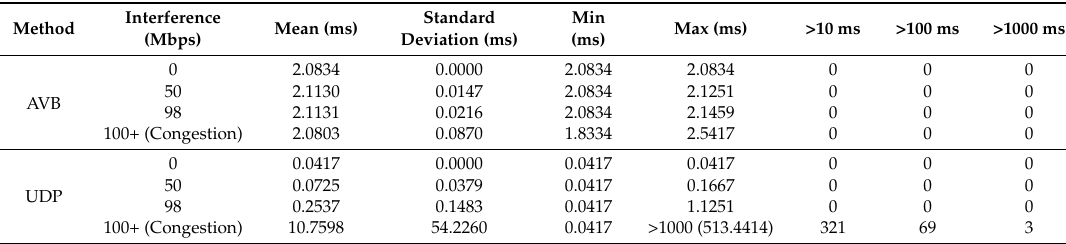
Table 2. Tabulation of experiment one results. User datagram protocol (UDP) and audio video bridging